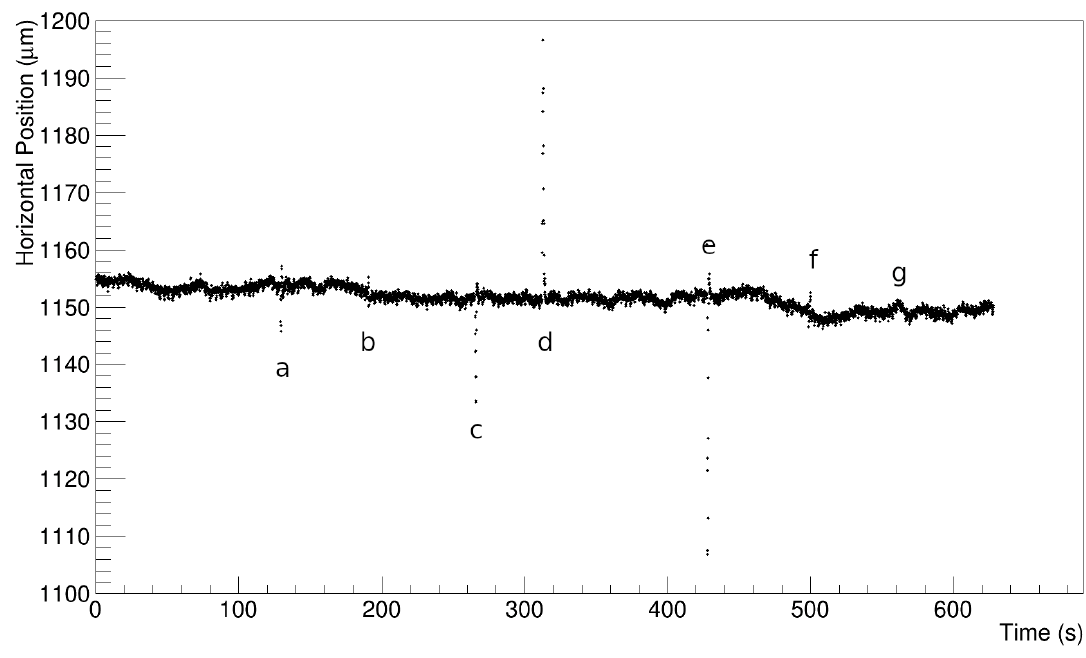
Figure 10. Horizontal X-ray beam position observed by NanoMAX. The points where large perturbations (points “c”, “d”, and “e”) are observed, correspond to direct bump changes performed in the same plane for the BioMAX beamline. See main text for details.